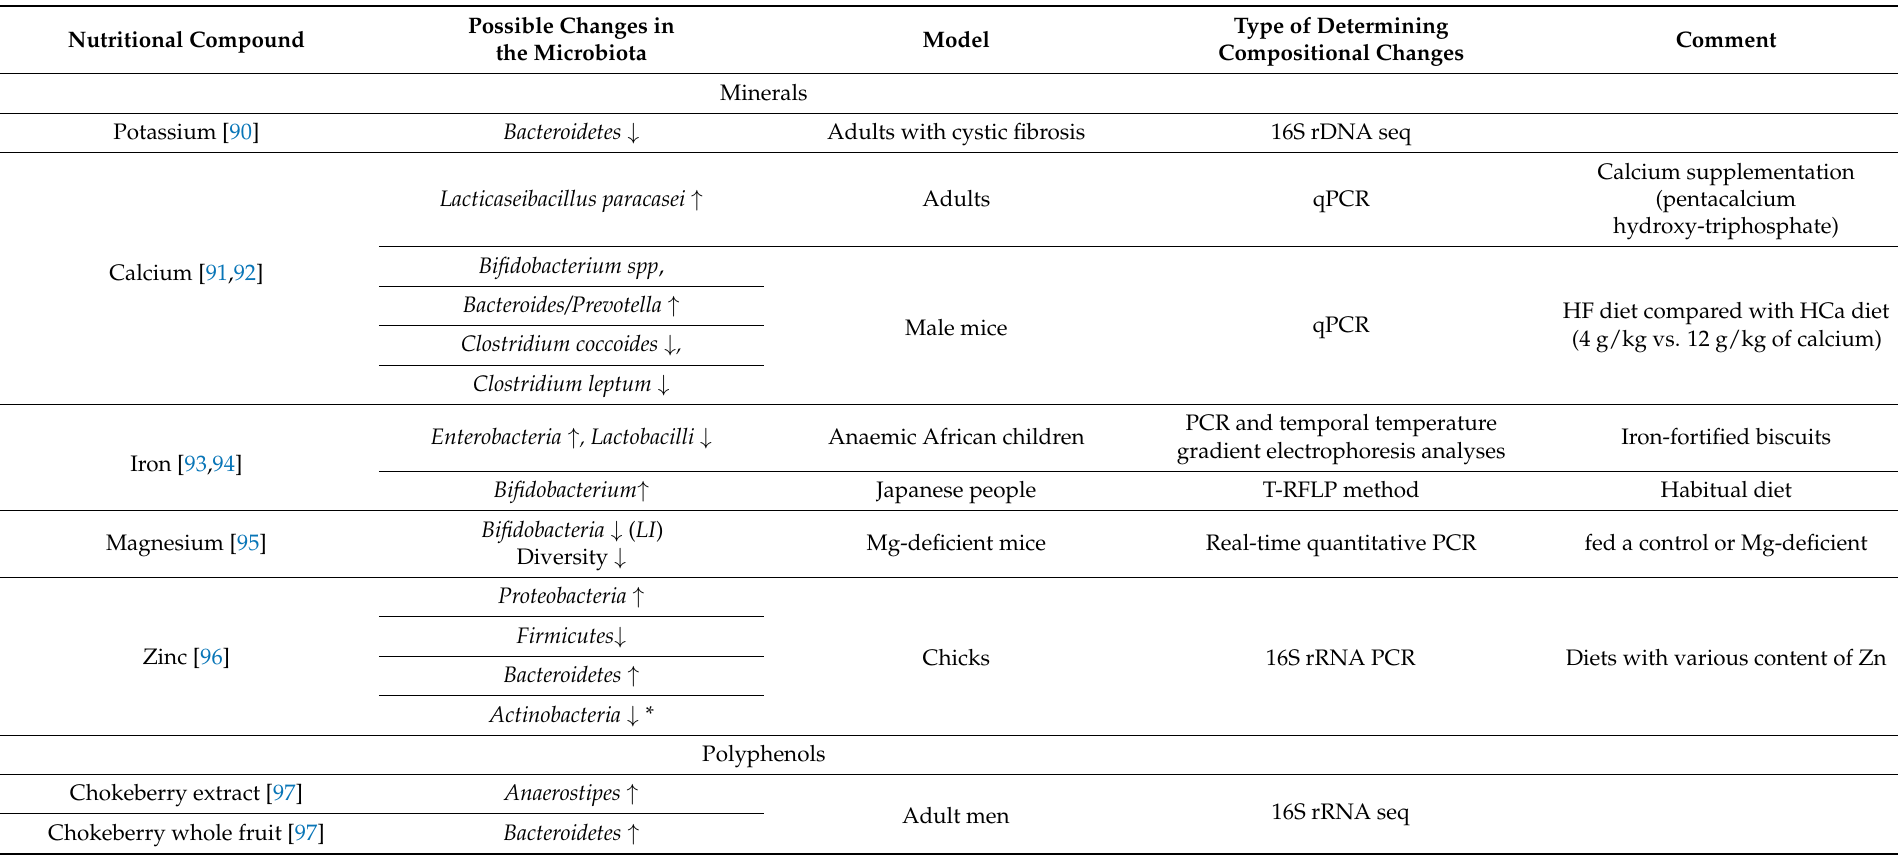
Table 4. The influence of nutritional compounds on the composition of the intestinal